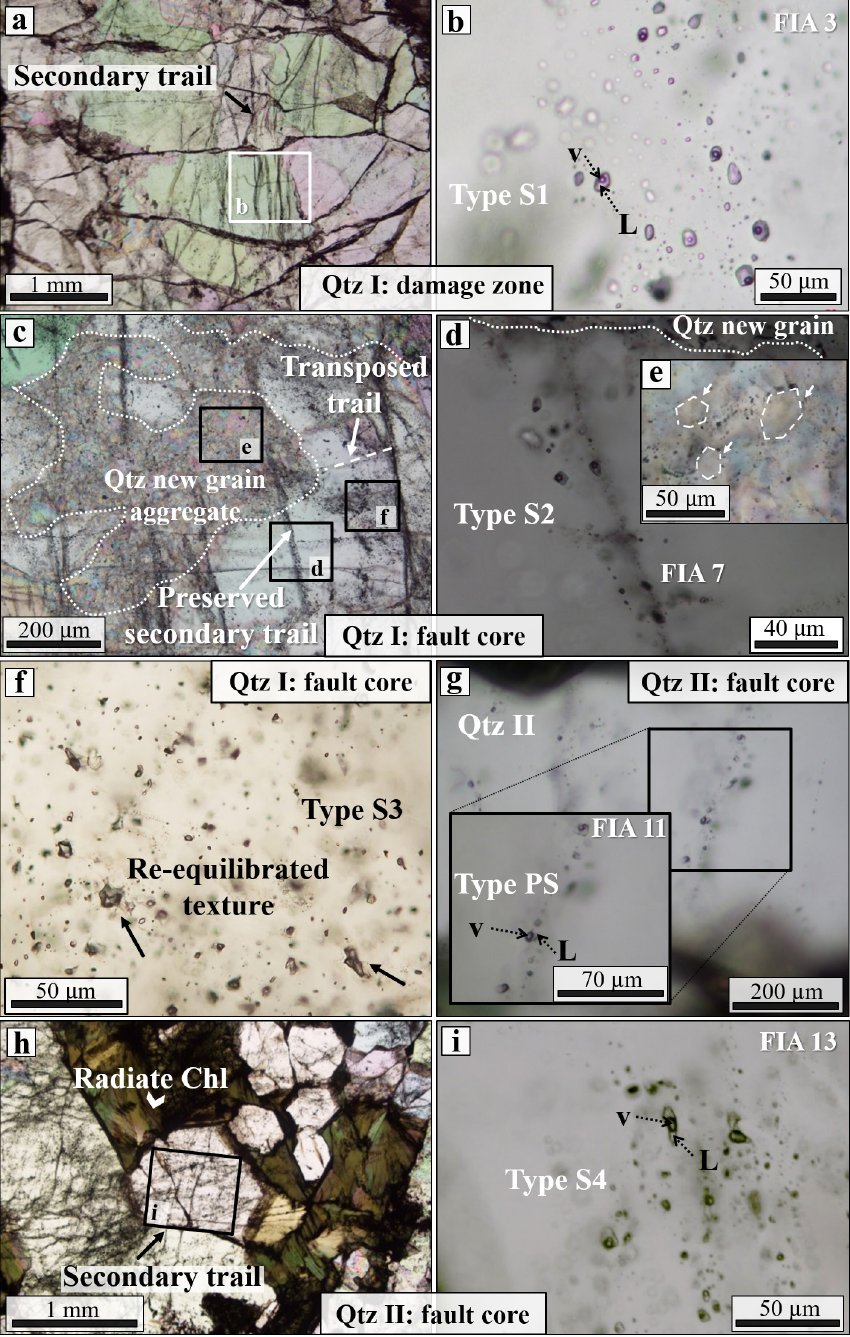
Figure 9. Characteristic textures of FIAs hosted within the BFZ300 quartz (samples PH21, TPH-120-4, TPH-120-6). (a) Secondary trails cross-cutting large Qtz I crystals of the damage zone. (b) Detail of (a) showing the phase ratios of one of the studied secondary assemblages (FIA 3), most representative of Type S1 FIA. (c) Long secondary transgranular trails cross-cutting Qtz I of the fault core, dismembered by intercrystalline fractures, infilled by quartz new grains. Qtz I fault core also hosts a set of short sub-trails developed at a high angle with respect to the long trails. (d) Detail of Type S2 FIA entrapped along a preserved secondary fracture trail. (e) Small inclusions (<1µm) arranged along the boundaries of new polygonal quartz. (f) Example of Type S3 FIA arranged as isolated clusters inside ductile-deformed fault core Qtz I. These trails formed during a brittle deformation stage that predates ductile re-crystallization. (g) Pseudosecondary FIA associated with Qtz II chlorite (FIA 11). The enlargement shows the phase ratio details. (h) Small-scale view of secondary FIAs cross-cutting Qtz II. (i) Detail of secondary trails cross-cutting euhedral Qtz II (FIA 13). In all photographs north points up.